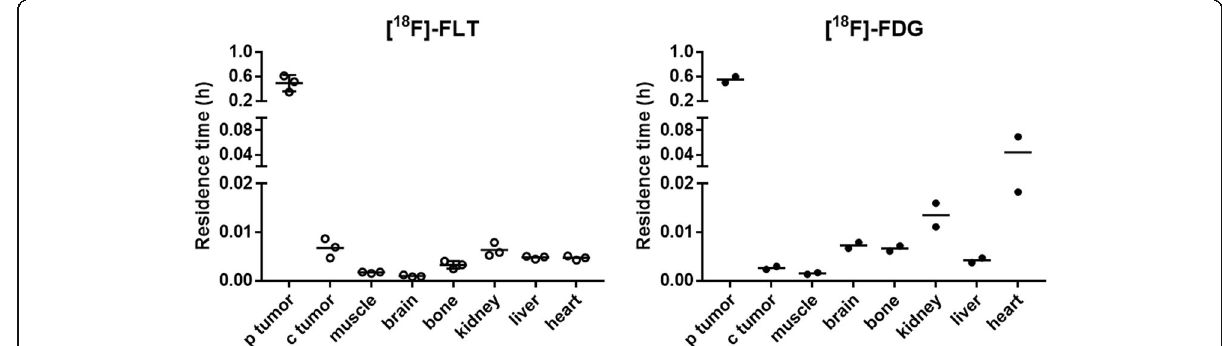
Fig. 4 Residence time of 18 F-FLT and 18 F-FDG in each tissue. Residence times were calculated as areas under the time-activity curves shown in Figs. 2 and 3 extrapolated to infinity with the physical decay of 18 F. The horizontal bars stand for the